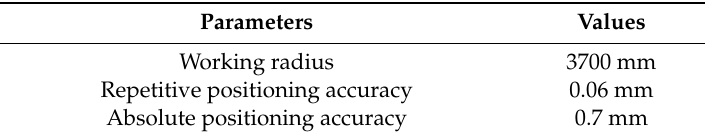
Table 2. Specifications of KUKA robot KR 90 R3700 prime K.